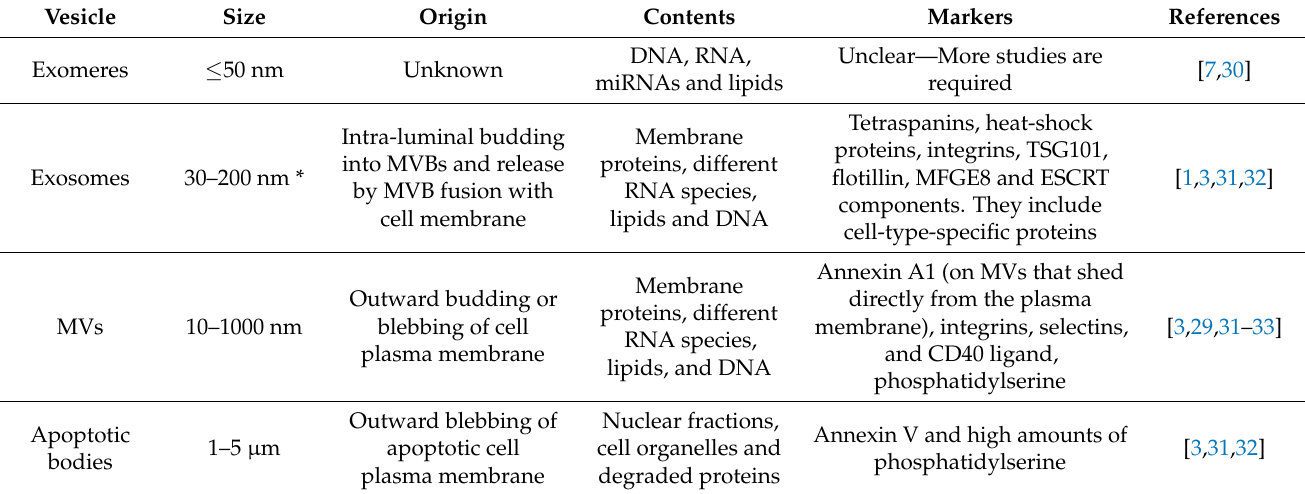
Table 1. The different types of extracellular vesicles and their defining characteristics.: miRNA, microRNA; MVs,